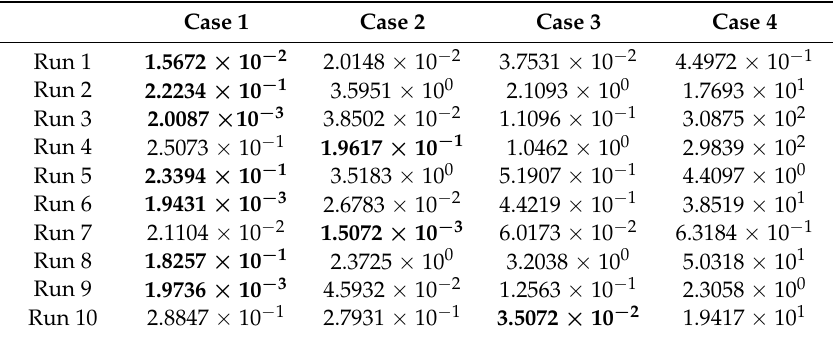
Table 2. Mean inverted generational distance (MIGD) values over 10 runs for each case of distributed energy resources (DER)